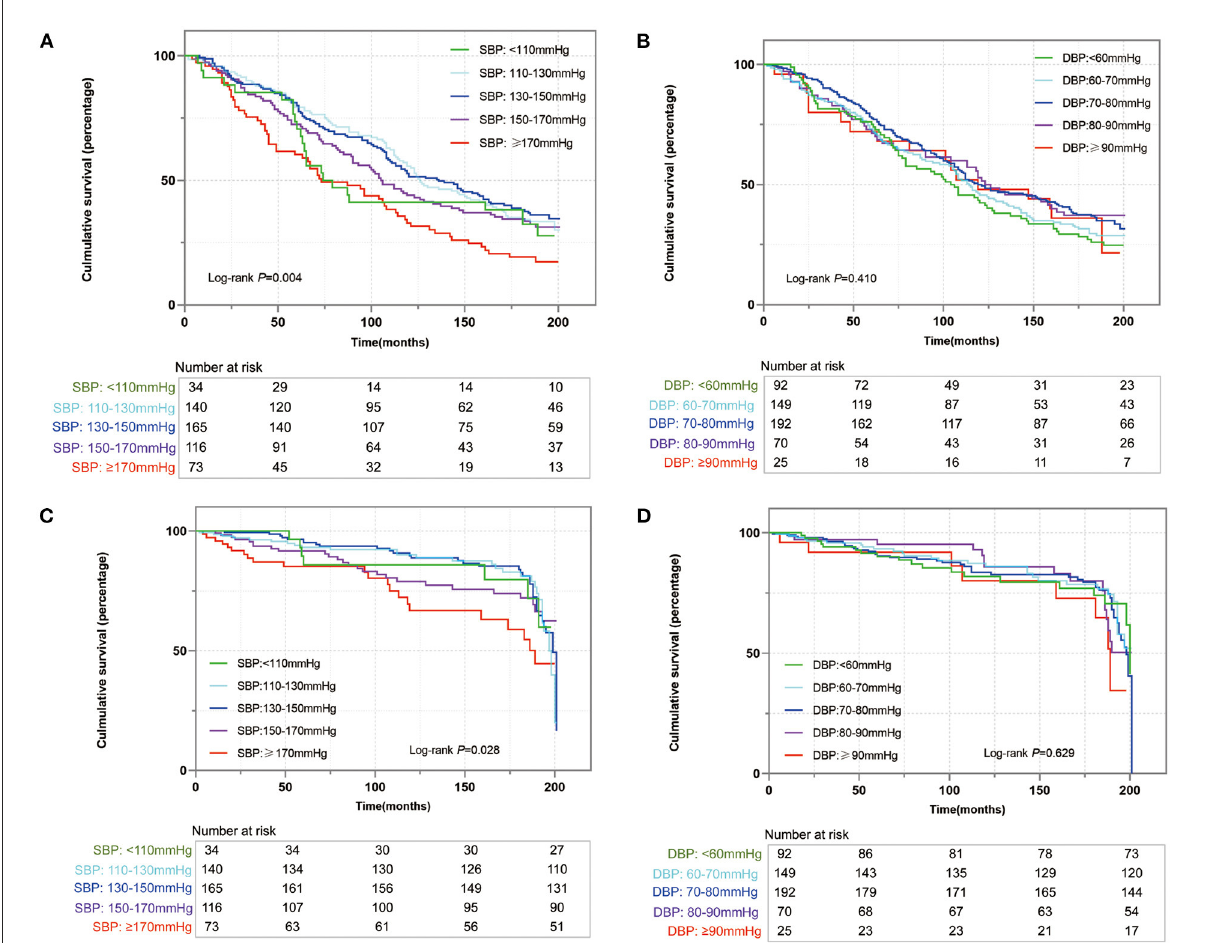
FIGURE1 The Kaplan–Meier analysis of all-cause mortality (A) and cardiac mortality (C) for systolic blood pressure (SBP), and all-cause mortality (B) and cardiac mortality (D) for diastolic blood pressure